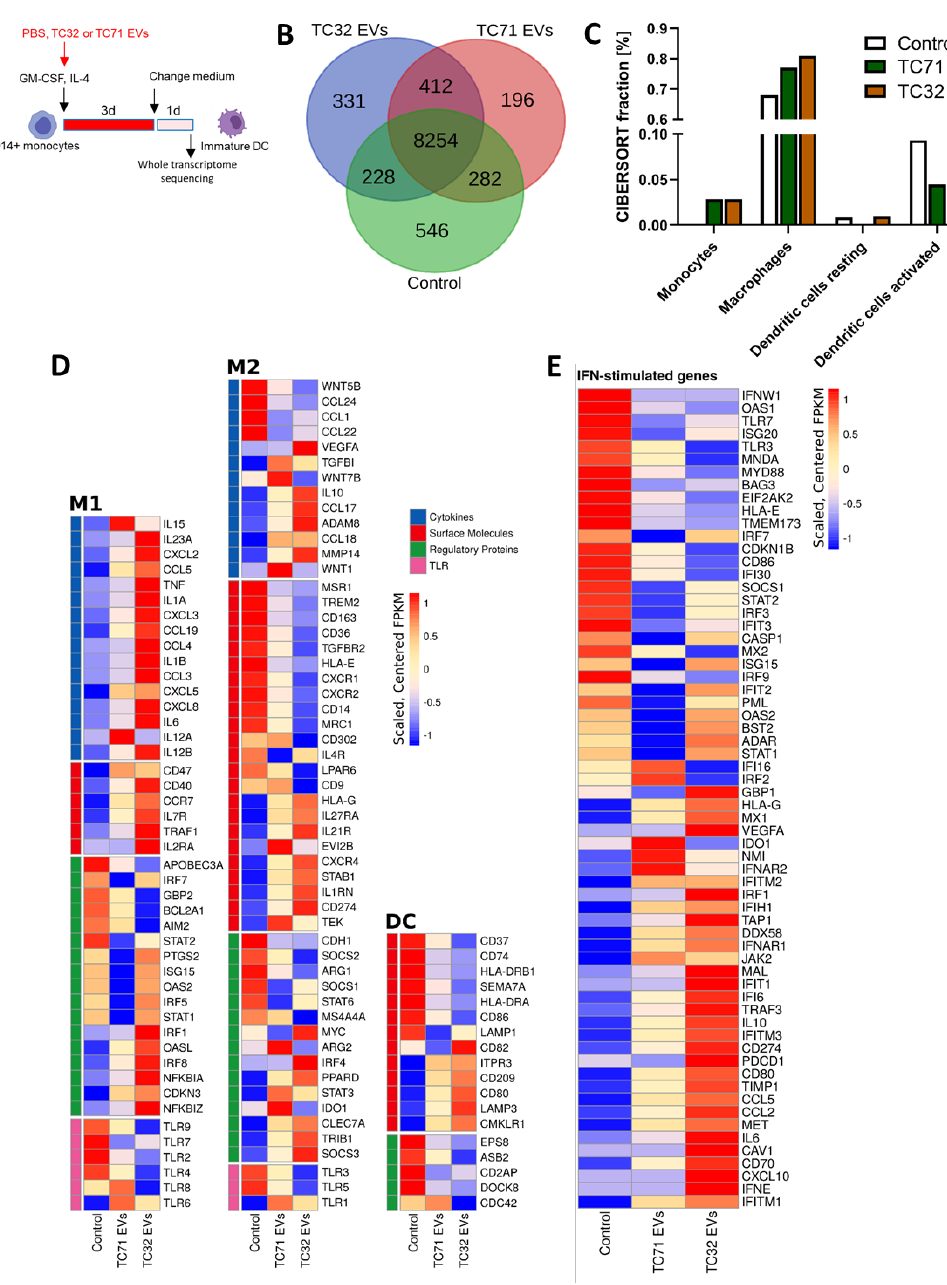
Figure 4. EwS EVs rewire gene expression programs associated with inflammatory responses and the maturation of myeloid cells. Experimental design ( A ) and whole transcriptome analysis ( B – E ). CD14 + monocytes were differentiated with the GM-CSF and IL-4 cocktail for 4 days in the presence of EVs from TC32 or TC71 EwS cells, or PBS (control), and subjected to RNA-seq. ( B ) Venn diagram showing an overlap between the sets of expressed genes ( ≥ 10 FPKM) in EV-treated and control cells. ( C ) CIBSESORT analysis of the identified mRNAs. The plot shows the four most represented immune cell sub-populations in EV-treated and control cells. ( D , E ) Heatmaps of the M1, M2, and DC ( D ) and IFN-type I/III ( E ) signature genes using the customized MSigDB Hallmark gene sets. Data represent expression values sorted according to fold change in TC32 and TC71 EV-treated CD14 + cells compared to control. Visualizations were done using FPKM values generated with cufflinks, scaled, and centered prior to plotting. Genes shown in ( D ) are grouped in the categories cytokines ( blue ), surface molecules ( red ), regulatory proteins ( green ), and toll-like receptors (TLR, pink